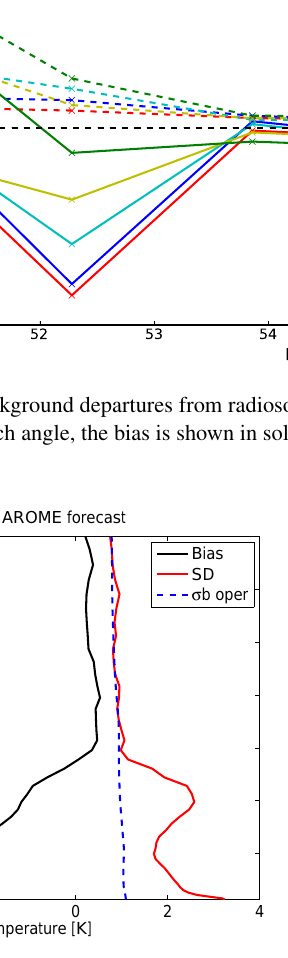
Figure 8. Bias (black line) and standard deviation (red line) of the radiosonde minus 1h AROME temperature differences. The oper- ational background error used in AROME for the assimilation of satellite data is shown as the blue dashed